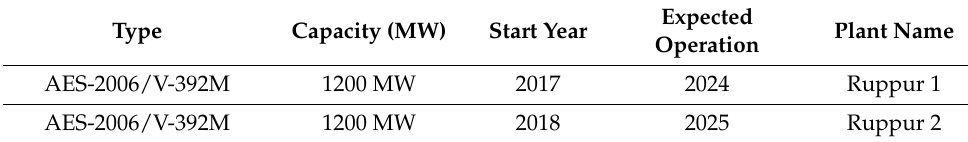
Table 3. Ruppur 1 and Ruppur 2 nuclear power plant plan